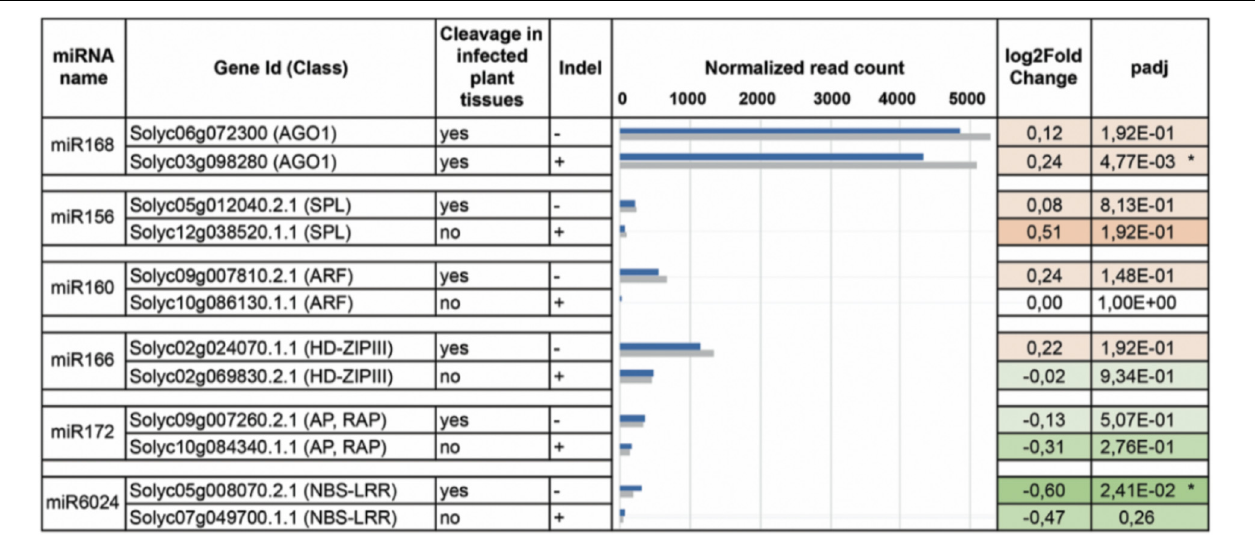
FIGURE 5 | DEseq analysis. Paralogs for each miRNA-targeted (column 1) gene family (column 2) have been analyzed by DESeq. Corresponding transcripts are either cleaved in the virus-infested tissues or not (column 3). For each family, only one of the two paralogs contains the indel (column 4). In column 5 the normalized read counts for mRNAs purified from both virus-infected (gray bars) and mock-inoculated (blue bars) tissues. In column 6 and 7, log2FoldChange and adjusted p -values are displayed in the heatmap: red and green for up- and down-regulated transcripts. Asterisks indicate statistically significant variations that were also confirmed by qRT-PCR (three biological replicates and two technical